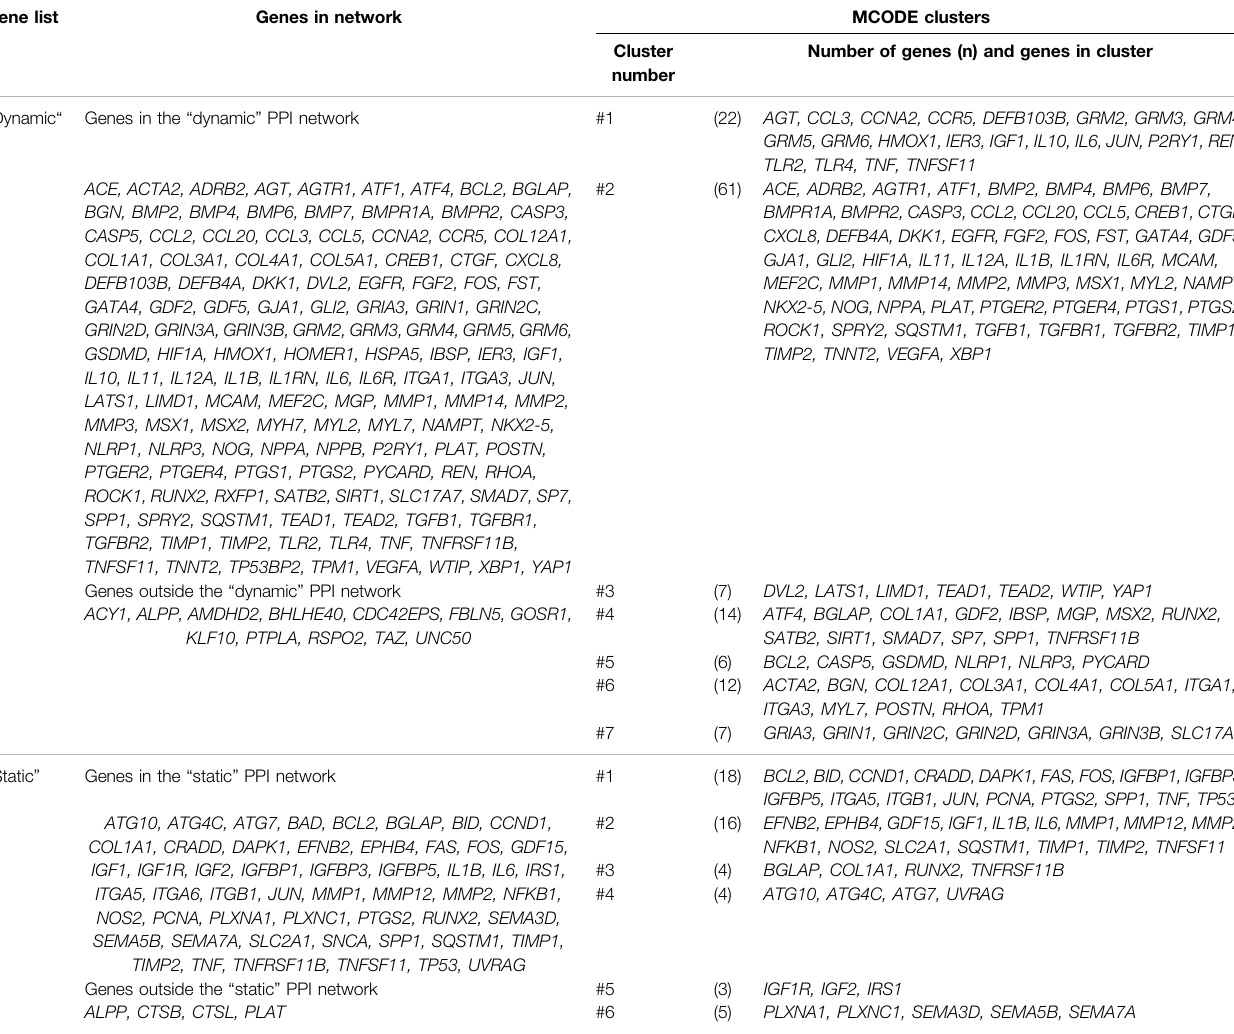
TABLE4| Differentialexpressedgenes(DEGs)fromthe “ dynamic ” and “ static ” genelistsandtheiraf fi liationtothe “ dynamic ” and “ static ” protein-proteininteractionnetworks and one of the MCODE clusters. The corresponding networks and clusters were depicted in Figure 5